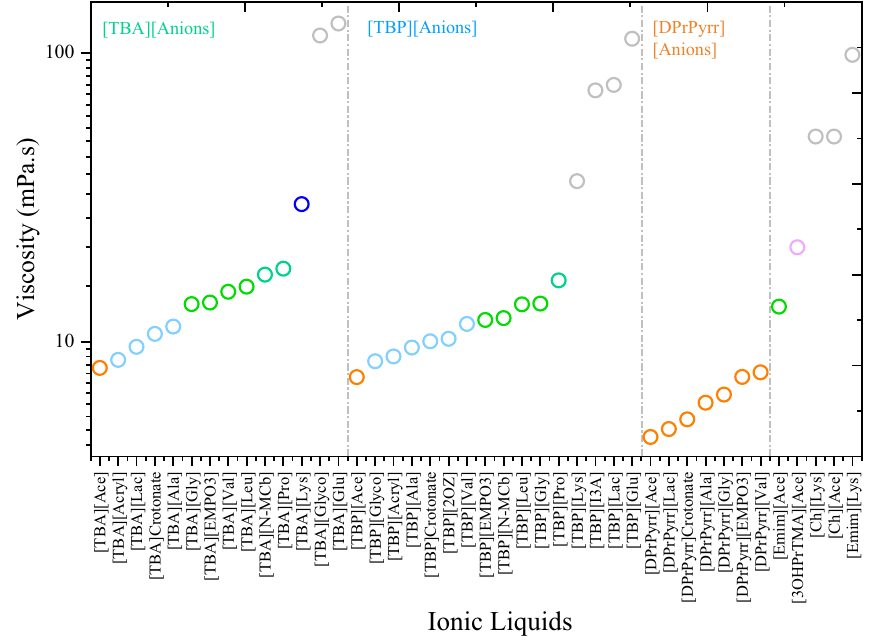
Figure 5. COSMO-RS-based predicted viscosities of pure ionic liquids at 363.15 K. COSMOTherm version 19.0.1 was used to calculate the sigma potentials (https:// www. 3ds. com/ produ cts- servi ces/ biovia/ produ cts/ molec ular- model ing- simul ation/ solva tion- chemi stry/ biovia- cosmo